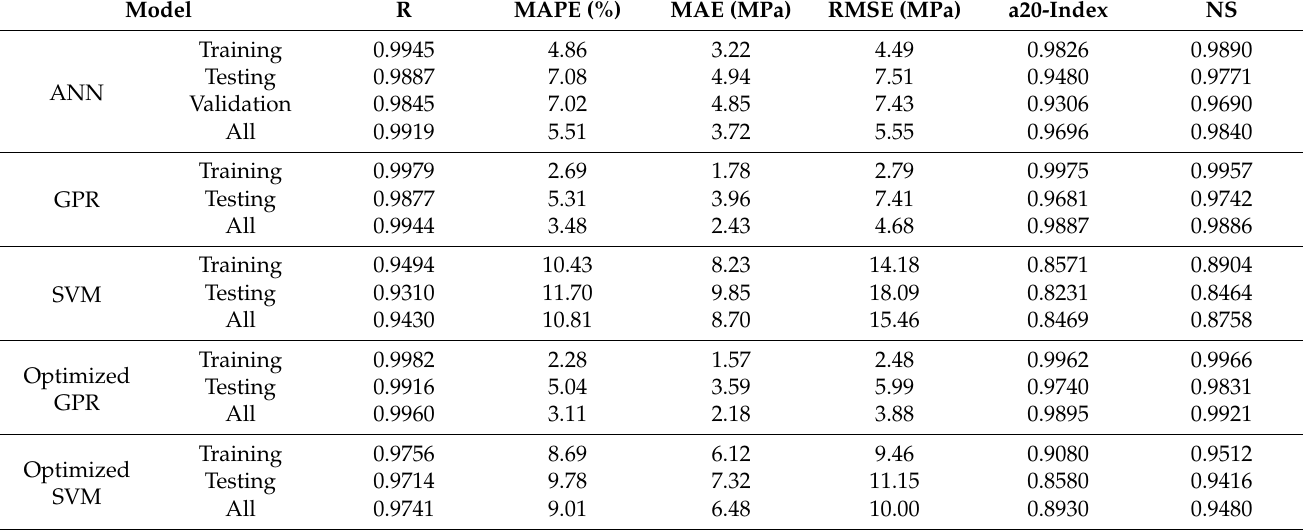
Table 5. Comparison of ML models based on statistical